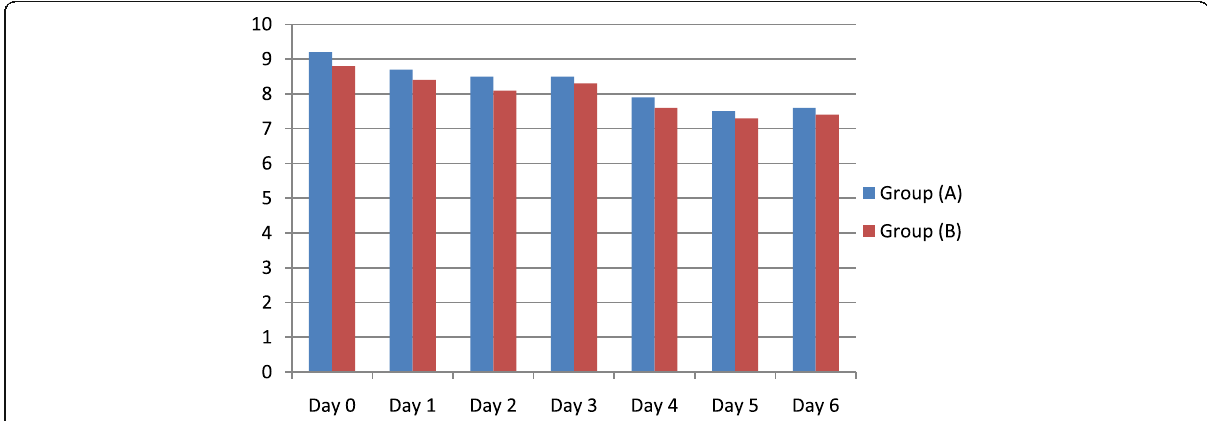
Fig. 5 Bar chart showing the comparison between group A (control) and group B (esmolol) according to